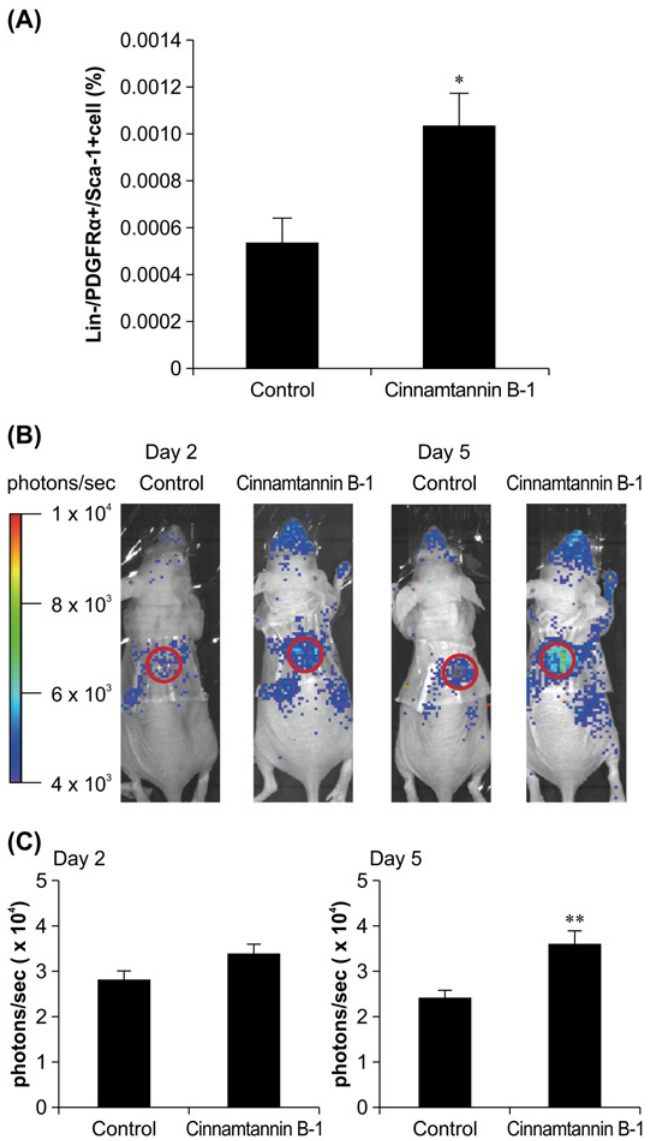
Fig 1. Effects of cinnamtannin B-1 on migration of mouse mesenchymal stem cells (MSCs). (A) Increase in population of Lin − /PDGFR α +/Sca-1+ peripheral blood mononuclear cells of mice after systemic administration of cinnamtannin B-1, n = 6 per group. * P < 0.05 vs. control. (B) KUM6 cells localized in wound healing models; ffLuc-expressing KUM6 cells were injected 4 days after surgical incision (day 1). Images of a representative animal are shown on day 2 and 5 after ffLuc-KUM6 cell injection. (C) Quantification of photon counts at wound site on day 2 and 5 (n = 8 – 9 and 6 – 7, respectively); ** P < 0.01 vs. control.